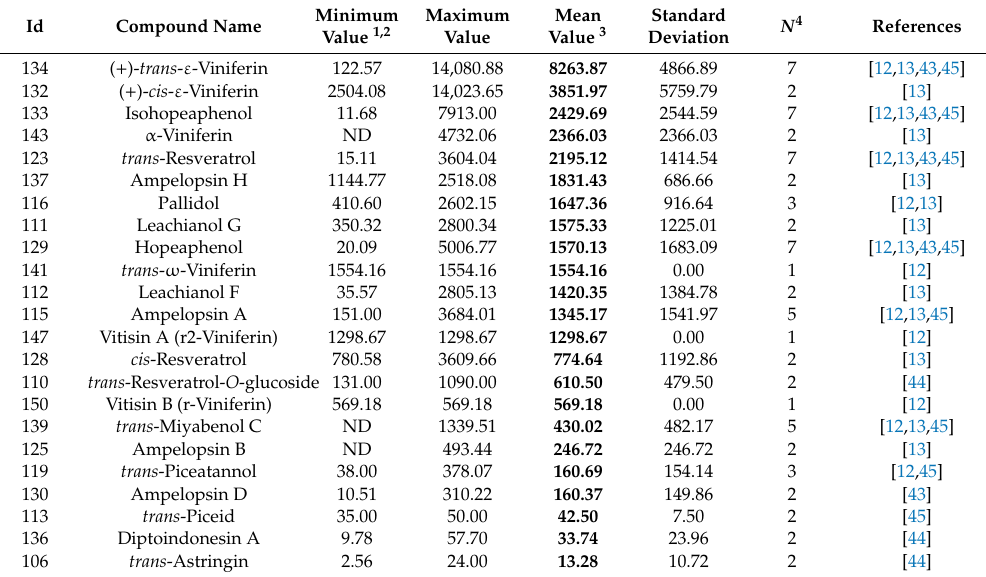
Table 9. Levels (mg / kg) of 23 stilbenic compounds identified in grapevine woods.